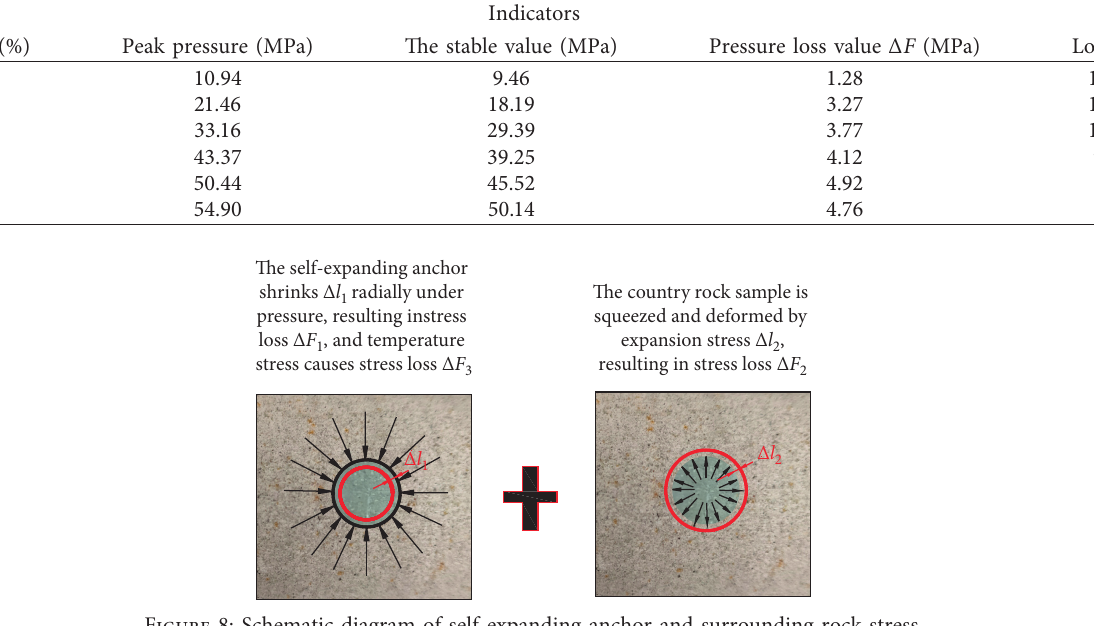
Table 1: Statistics of stress loss at various dosages under the initial confinement scheme of 0.7MPa.